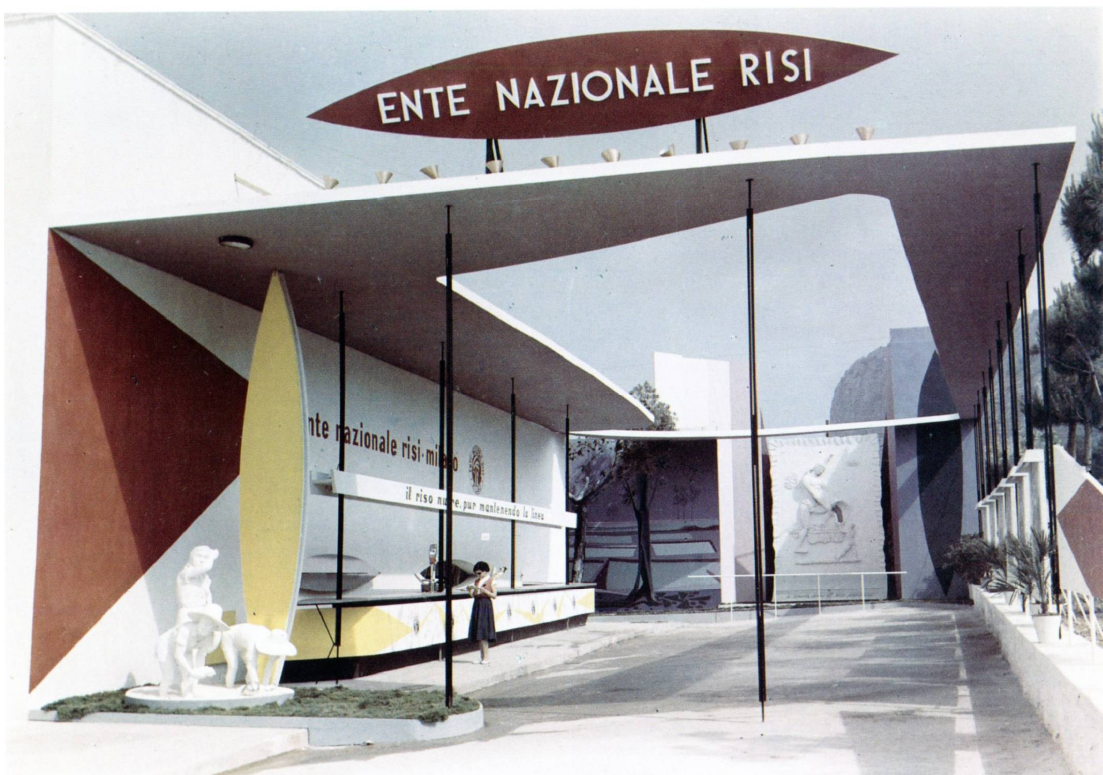
Figure 10. Ente Nazionale Risi Stand, 1956.